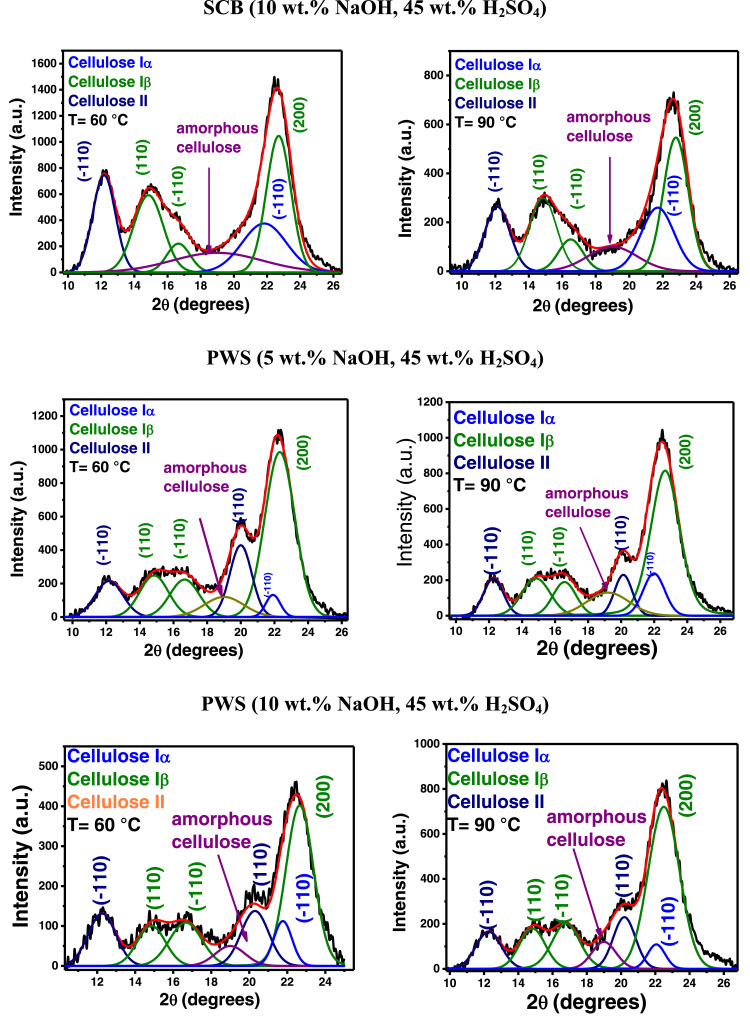
Separation of amorphous and crystalline phases in dependence of synthesis parameters, using the Shirley background subtraction with a Gaussian- Lorentzian profile of SCB (10 wt.% NaOH, 5 wt.% H2SO4, PWS (5 wt.% NaOH, 5 wt.% H2SO4 and PWS (10 wt.% NaOH, 5 wt.% H2SO4).